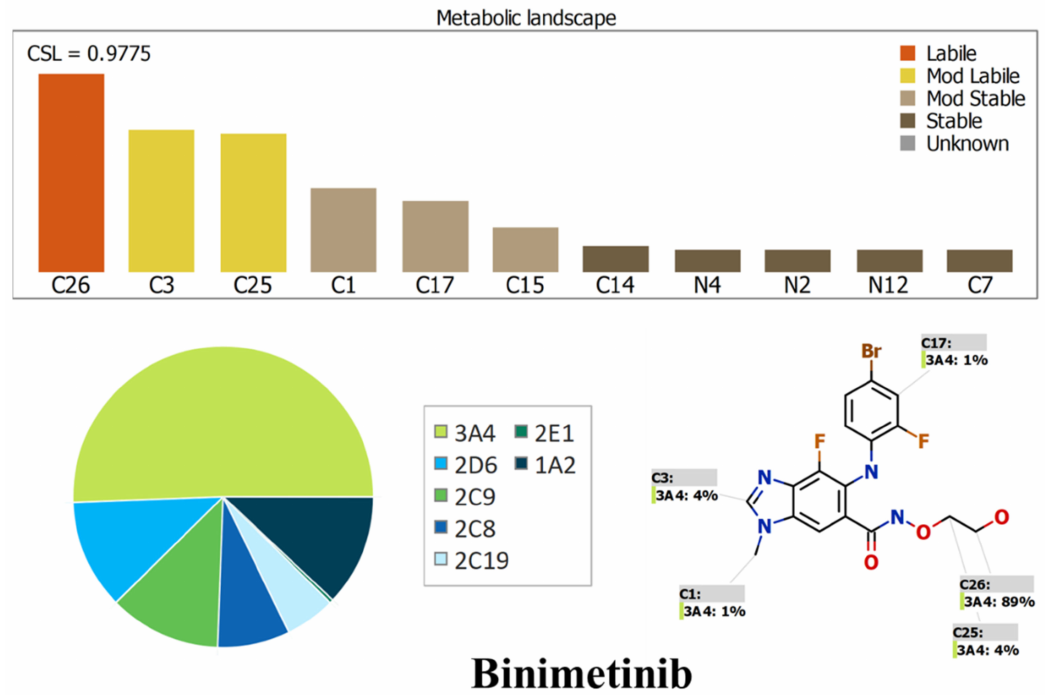
Figure 2. Proposed metabolic sites for BNB by StarDrop WhichP450™ module.